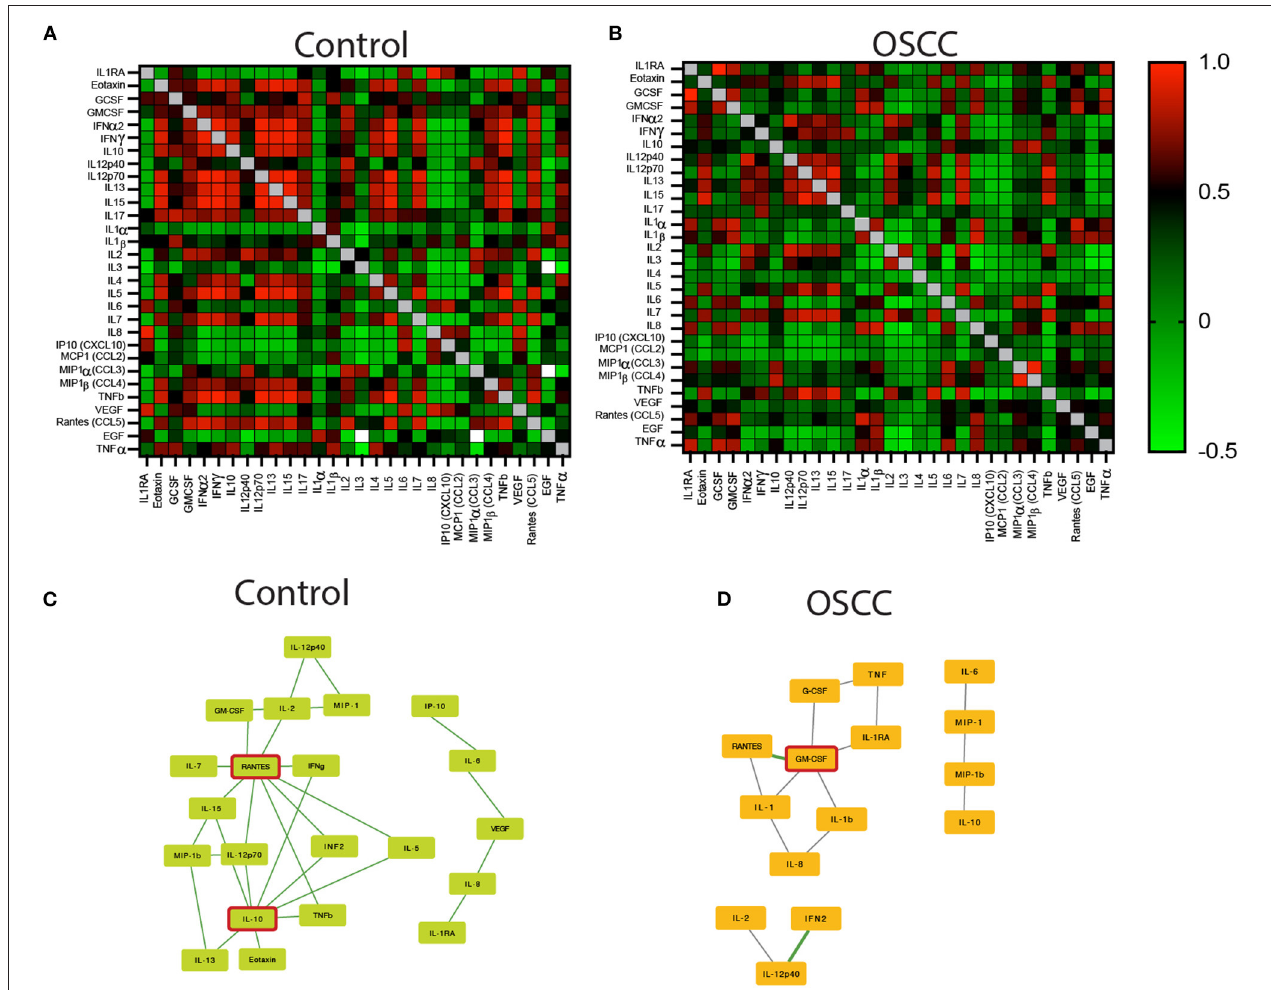
FIGURE 3 | Pearson’s correlation analysis between all cytokines in control and OSCC samples. The heatmap represents the r scores ( + 1 red to − 1 green). (A) Heatmap of Pearson’s correlation of the 30 cytokines in the saliva samples collected from controls. (B) Pearson’s correlation of the 30 cytokines in the saliva samples of OSCC patients. (C,D) A Cytoscape illustrations showing the interaction map of the selected cytokines with statistical differences between controls and OSCC samples. Illustrations are displaying the key role of IL-10 and Rantes/CCL5 in controls (C) , and GM-CSF in OSCC samples (D) ( n = 69).